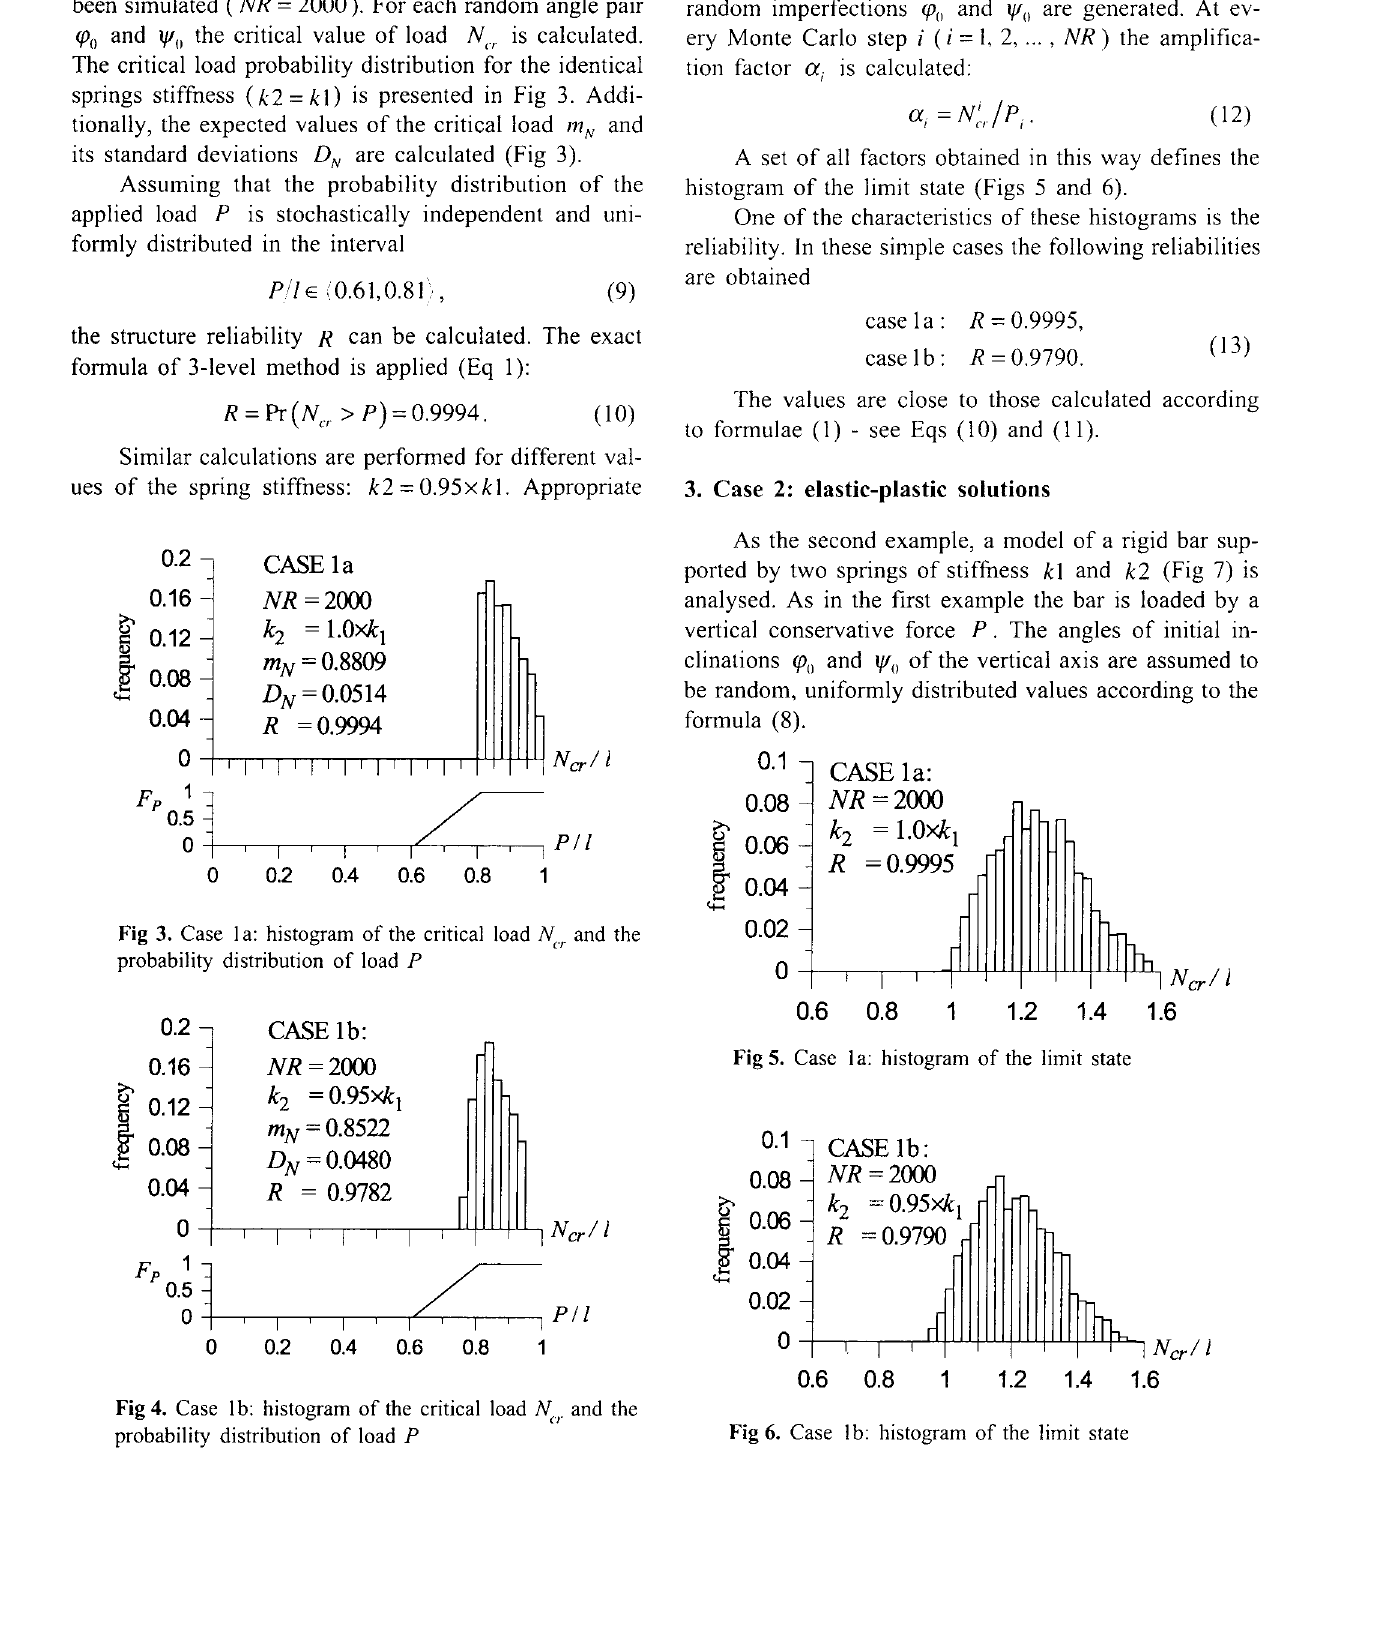
Fig 4. Case lb: histogram of the critical load N,,. and the probability distribution of load P